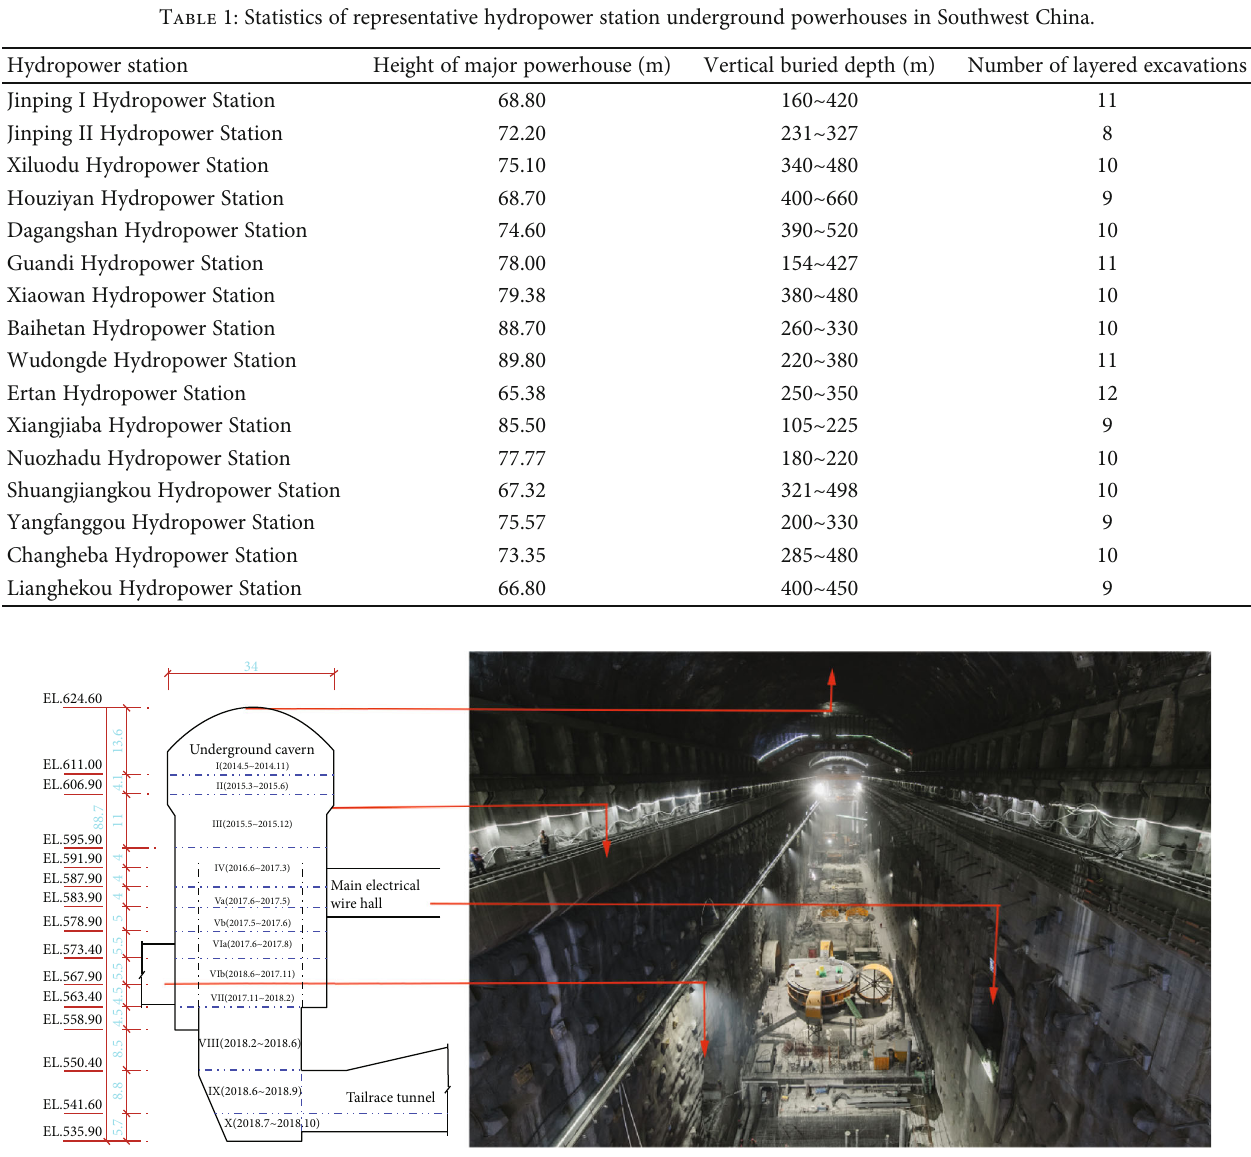
Instrument mounting base